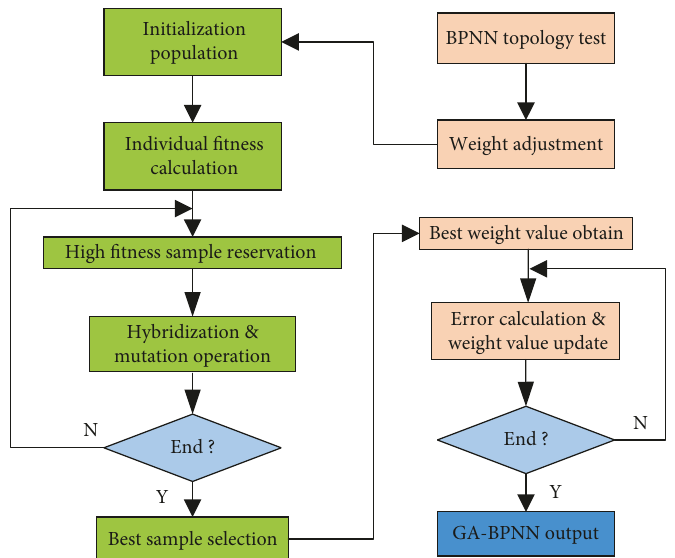
Figure 6: The fl ow chart of the proposed